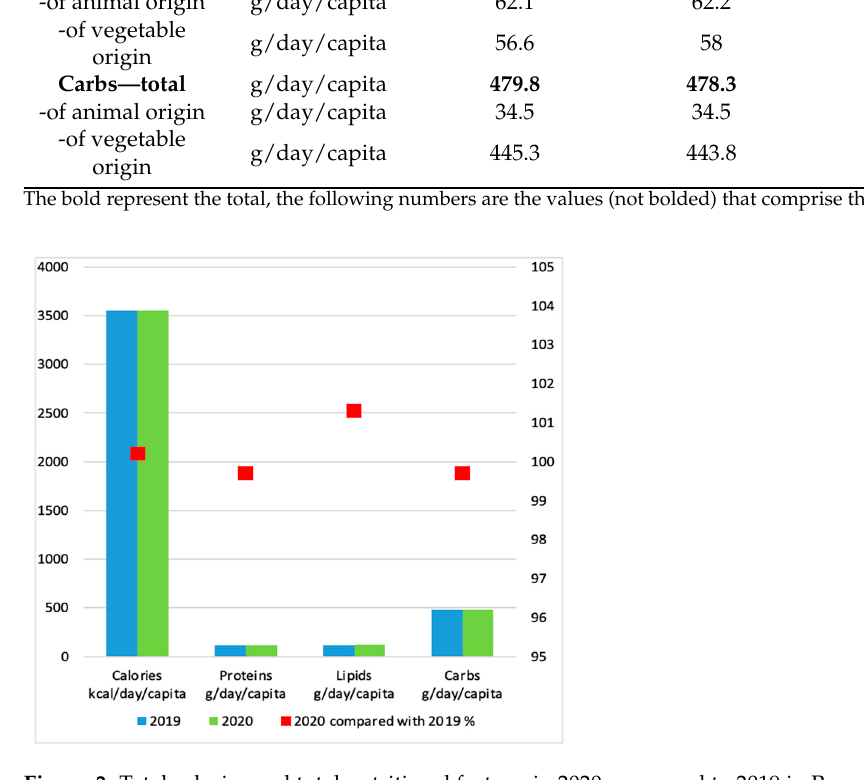
Figure 3. Total calories and total nutritional factors, in 2020 compared to 2019 in Romania of average daily food consumption per inhabitant